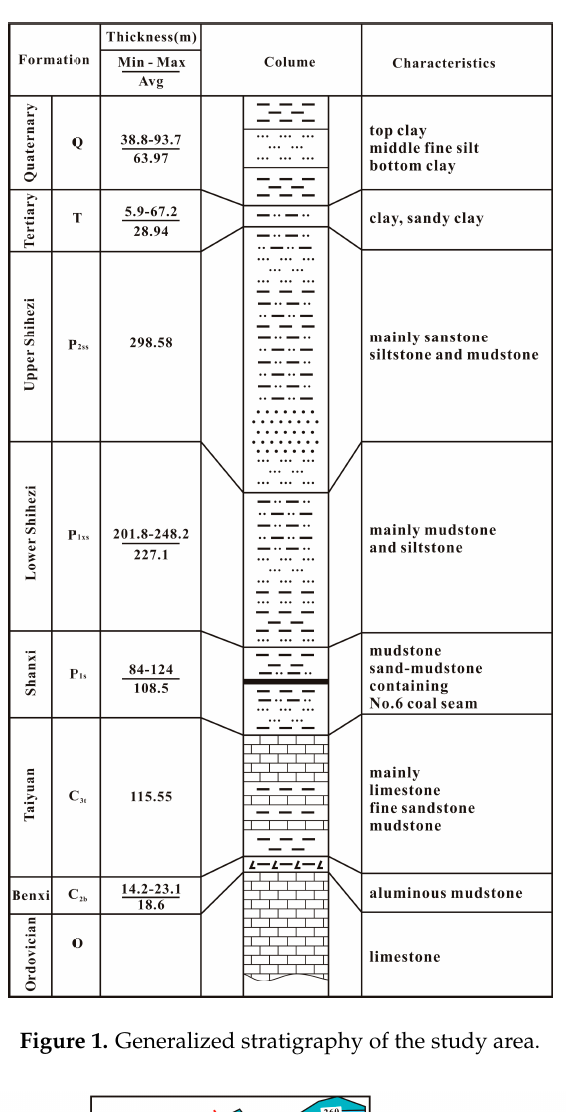
Figure 1. Generalized stratigraphy of the study area.